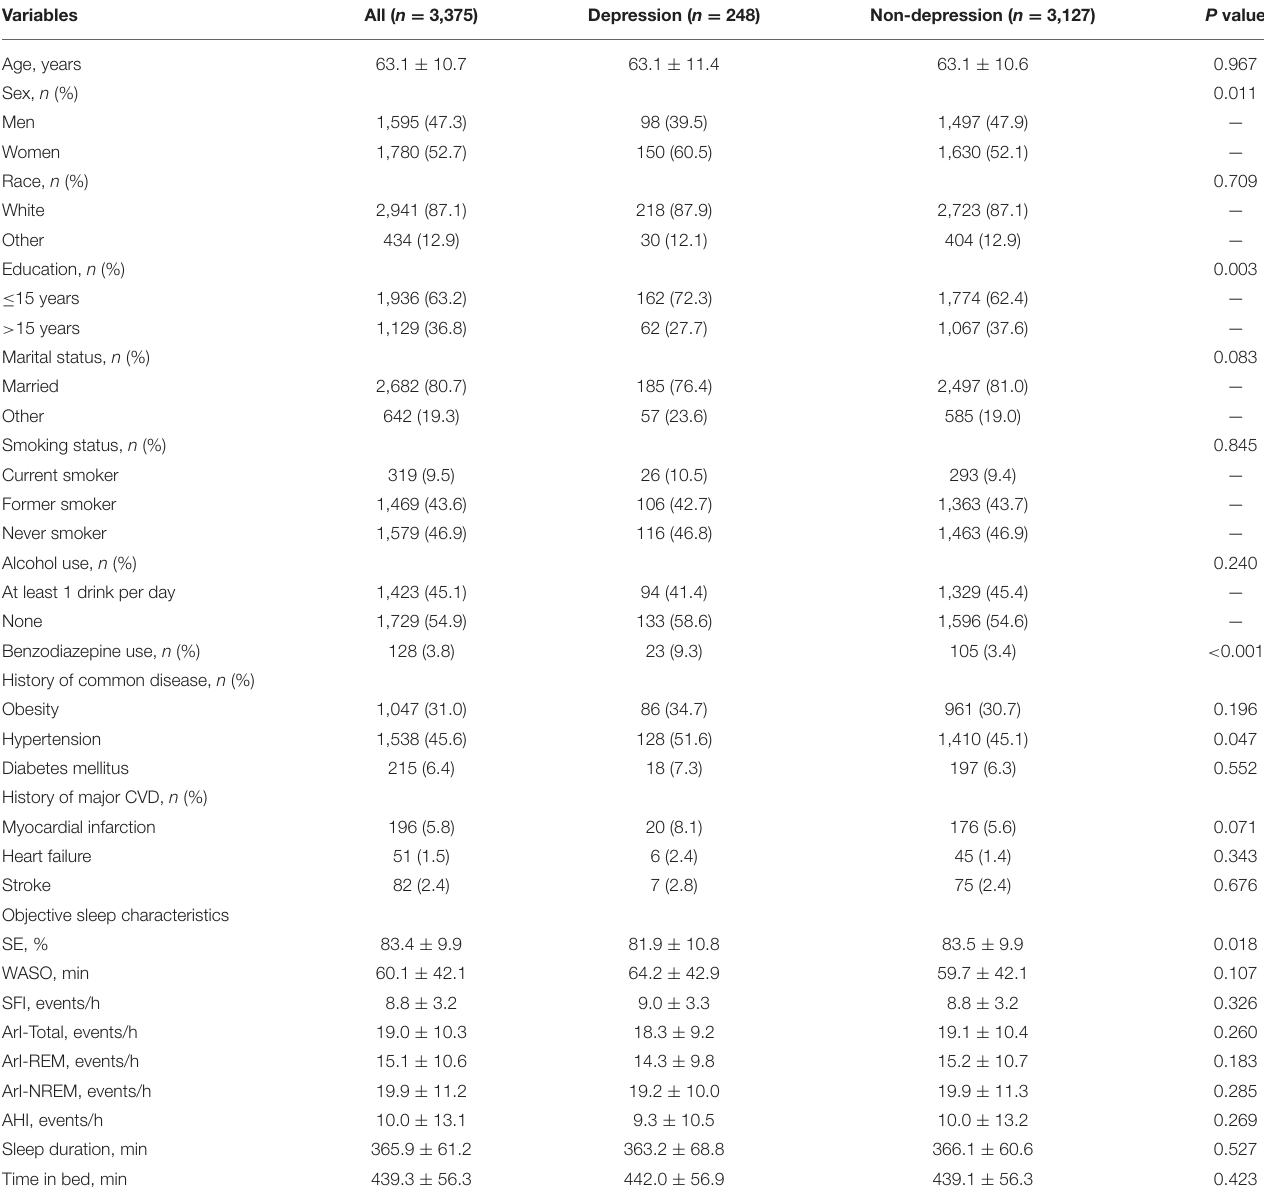
TABLE 1 | Subject characteristics in participants with or without